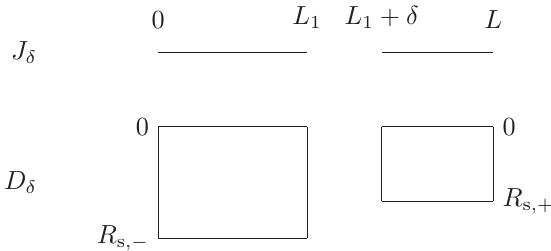
Figure 2: Domains J δ (spatial domain of definition of c e , φ e , ϕ s ) and D δ (spatial domain of definition of c s ). Notice that, since we are using a radial coordinate, every segment { x } × [ 0, R s ( x )] in D δ represents a ball { x } × B R